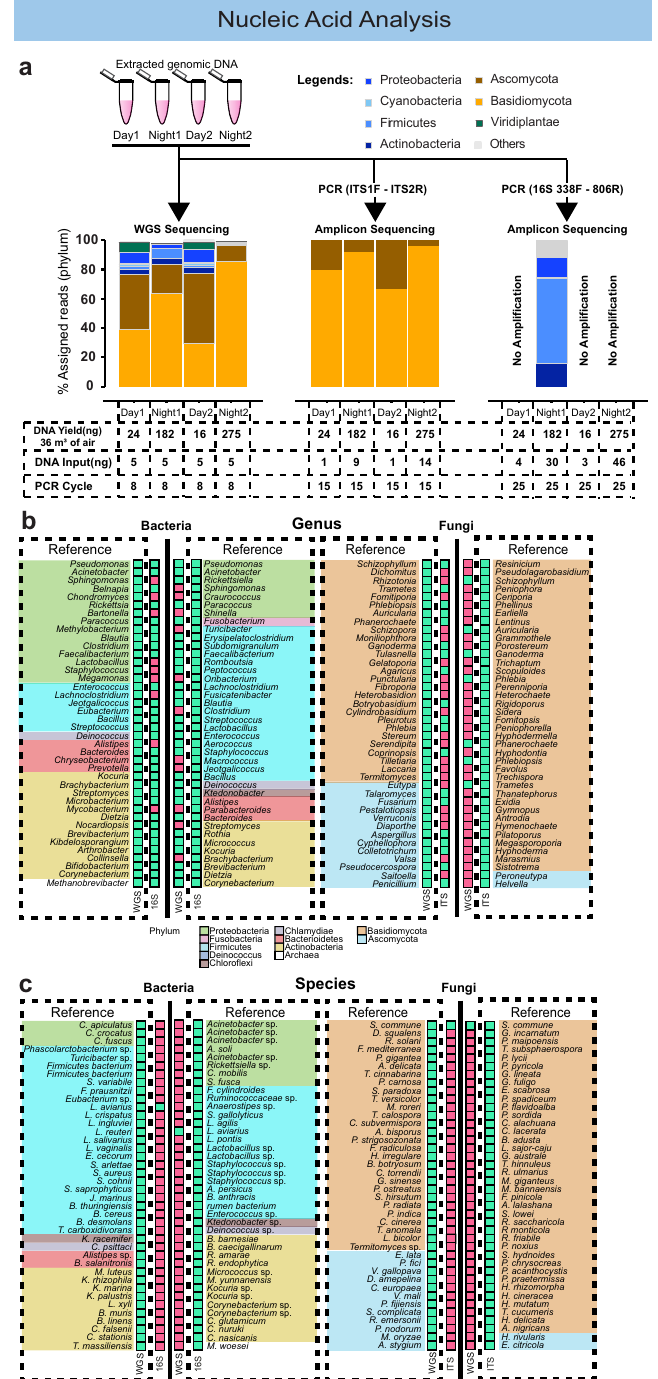
Fig. 6 Comparison of taxonomic pro fi les between WGS and amplicon sequencing pipelines. a Taxonomic pro fi le of WGS, ITS amplicon and 16S amplicon pipeline at phylum level of four independently collected air samples (two days and two nights). b Presence – absence comparison of the top 40 most abundant genus for bacteria (WGS vs 16S) and fungi (WGS vs ITS). c Presence – absence comparison of the top 40 most abundant species for bacteria (WGS vs 16S) and fungi (WGS vs